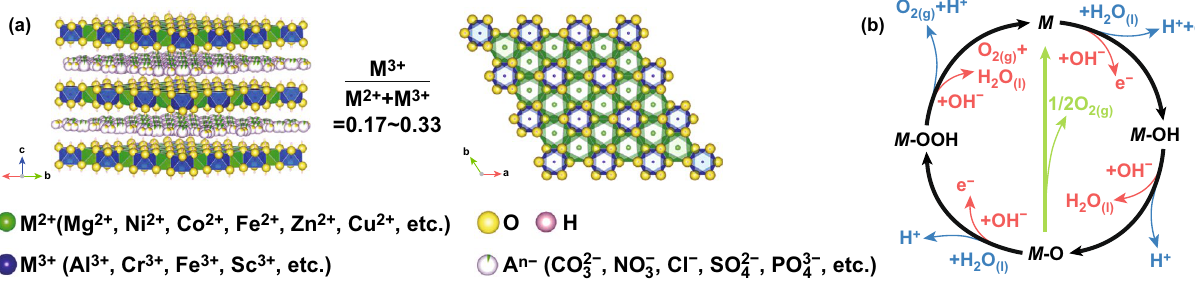
Fig. 1 a Typical structure model of LDHs and in‑plane cation arrangement. b OER mechanisms in acid (blue) and alkaline (red) conditions. Reproduced with permission from Ref. [23]. Copyright 2006 The Royal Society of